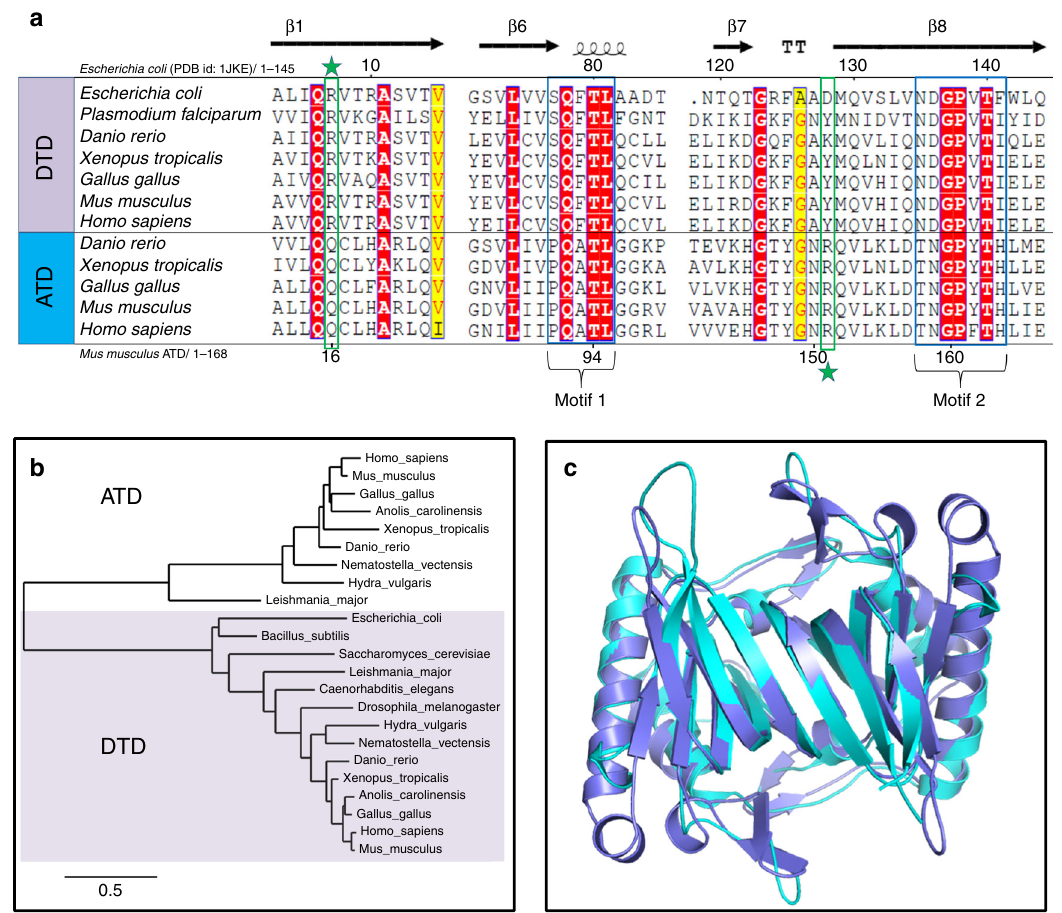
Fig. 1 ATD is a variant of DTD. a Multiple sequence alignment showing similar but distinct and characteristic sequence motifs in DTD and ATD (motifs 1 and 2). The highly conserved arginine in DTD (Arg7, EcDTD) is indicated by a star above, whereas the invariant arginine in ATD (Arg151, MmATD) is highlighted by a star below. b Phylogenetic classi fi cation of DTD and ATD showing their grouping into two separate categories. c Crystal structure of MmATD homodimer (blue) superimposed on that of PfDTD homodimer (cyan; PDB id: